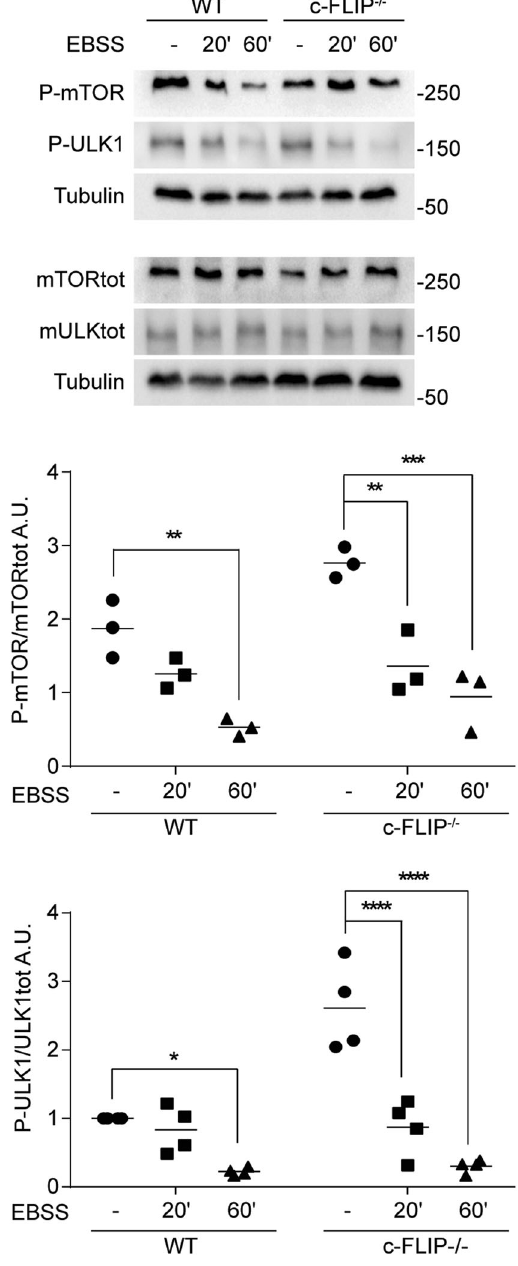
Fig. 2 WT and c-FLIP − / − MEFs were cultured in EBSS for increasing times (20 and 60 min). Total mTOR protein and its phosphorylation levels on Ser2448, and total ULK1 and its phosphorylation levels on Ser757 were evaluated by western blotting. Graphs show the ratio of P-mTOR on mTOR total protein and of P-ULK1 on ULK1 total protein. α -Tubulin was used as a loading control. Data shown are representative of at least three individual experiments. * p < 0.05, ** p < 0.01, *** p < 0.001, **** p < 0.0001 determined by two-way